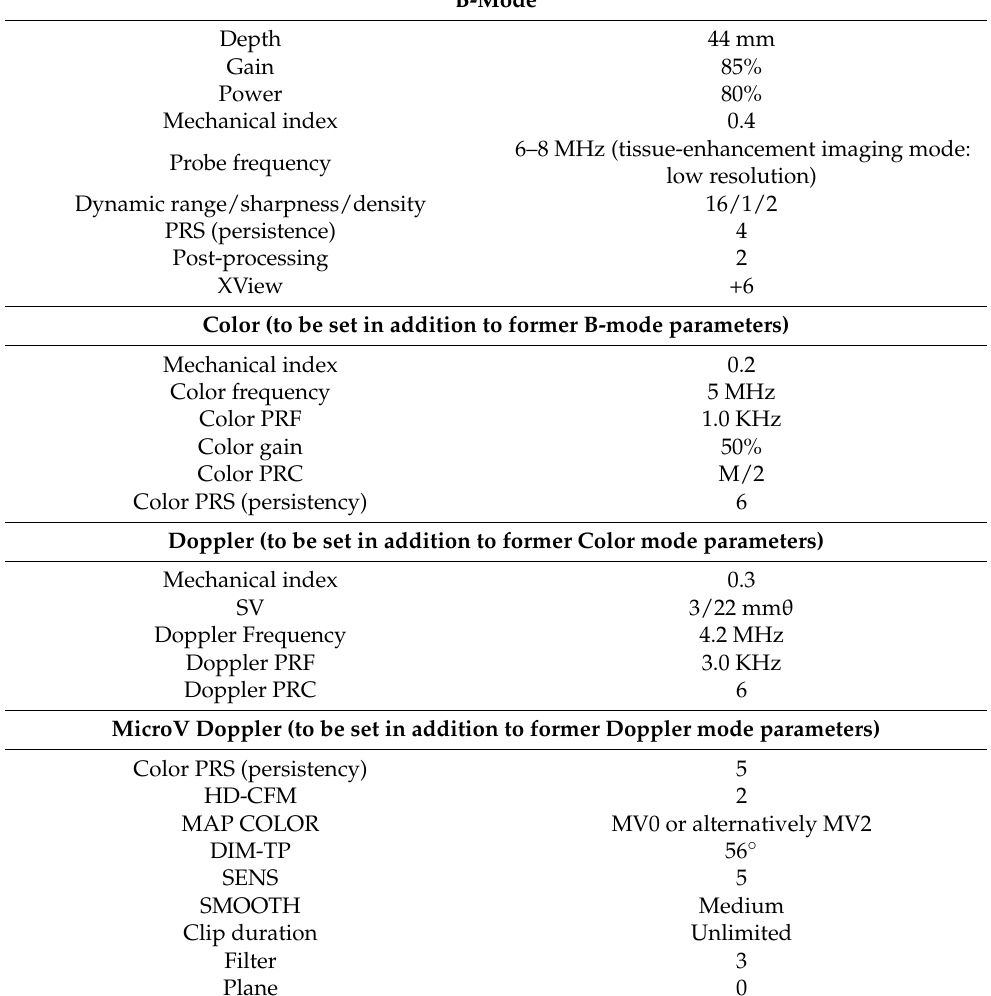
Table 1. Ultrasound parameters set for standardized MicroV IOUS image acquisition on Esaote MyLab Twice ultrasound machine according to the proposed